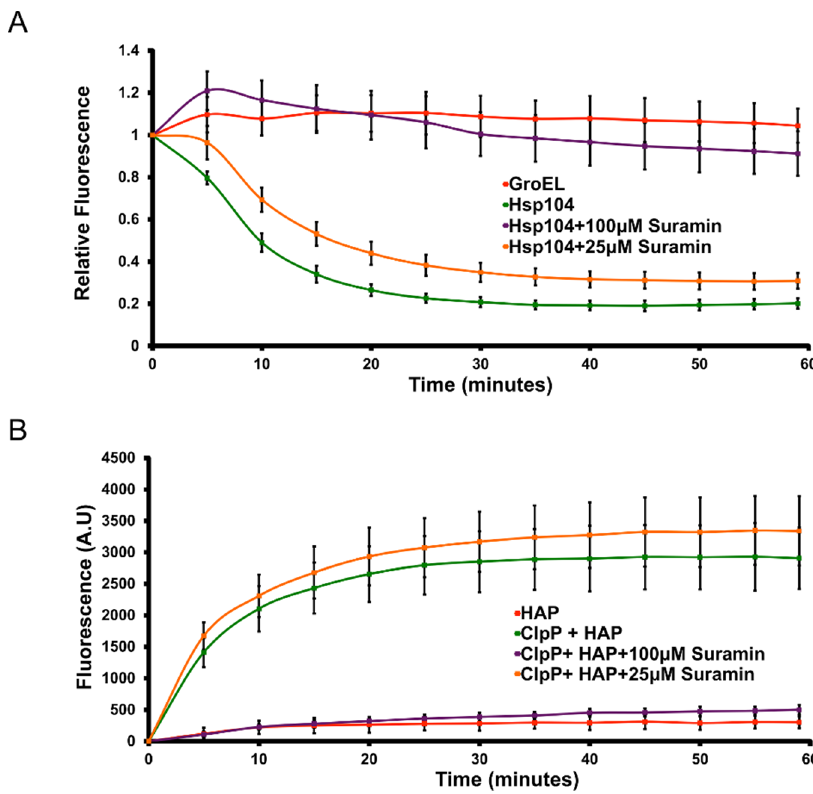
Figure 4. Suramin inhibits Hsp104-mediated substrate unfolding and translocation. ( A ) RepA 1–70 -GFP was incubated with Hsp104 WT and GroEL trap plus a 1:1 mixture of ATP and ATP c S. GFP unfolding was measured by fluorescence. GroEL trap alone is shown as a negative control (red line). Fluorescence values were normalized to initial raw fluorescence for each sample. Values represent mean 6 S.D. ( n =3). ( B ) FITC-casein (0.1 m M) was incubated at 25 u C with HAP (1 m M hexamer) and ClpP (21 m M monomer) plus ATP (5 mM) and an ATP regeneration system. Degradation of FITC- casein was monitored by fluorescence. Initial fluorescence was subtracted from raw fluorescence values for each sample. HAP alone is shown as a negative control (red line). Values represent mean 6 S.D. ( n =5). molecules ( Figure 1A , second column from the left). BSA, at a concentration of 0.1 mg/mL, also appeared to lessen the effect of the inhibitors, though to a smaller extent than Triton X-100 ( Figure 1A , third column from the left). Out of our initial ten inhibitors, we found Suramin and Cisplatin to most significantly inhibit Hsp104 ATPase activity in the presence of both Triton X- 100 and BSA ( Figure 1A , right column).